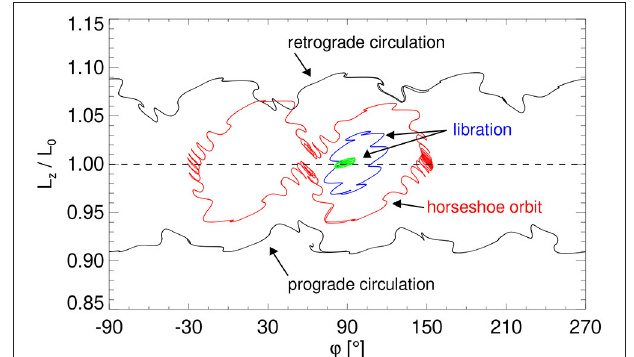
FIGURE 9 | Families of orbits for the Sun on the ϕ – L z / L 0 plane, parameterized by different values of the pattern speed (cid:127) p ; L 0 is the angular momentum of the corotation center, given by (cid:127) p R 2 CR . The orbits in black are circulating: prograde for (cid:127) p = 24, and retrograde for (cid:127) p = 30. The orbit in red is of the horseshoe–type orbit, which occur for the (cid:127) p –values of 25 and 29; these orbits oscillate around L z / L 0 = 1 and enclose two resonant islands. The orbit in blue is librating inside the local corotation zone, and occur for the (cid:127) p –values of 26 and 28. The orbit in green is for the (cid:127) p –value of 27 and it shows a libration motion with a very small amplitude of oscillation, indicating that the Sun would be very close to the corotation center. All the (cid:127) p –values given above are in units of kms − 1 kpc − 1 . Adapted from Lépine et al. (2017).